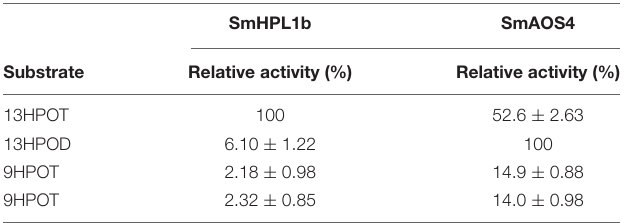
TABLE 1 | Substrate specificities of recombinant SmHPL1b and SmAOS4. SmHPL1b SmAOS4